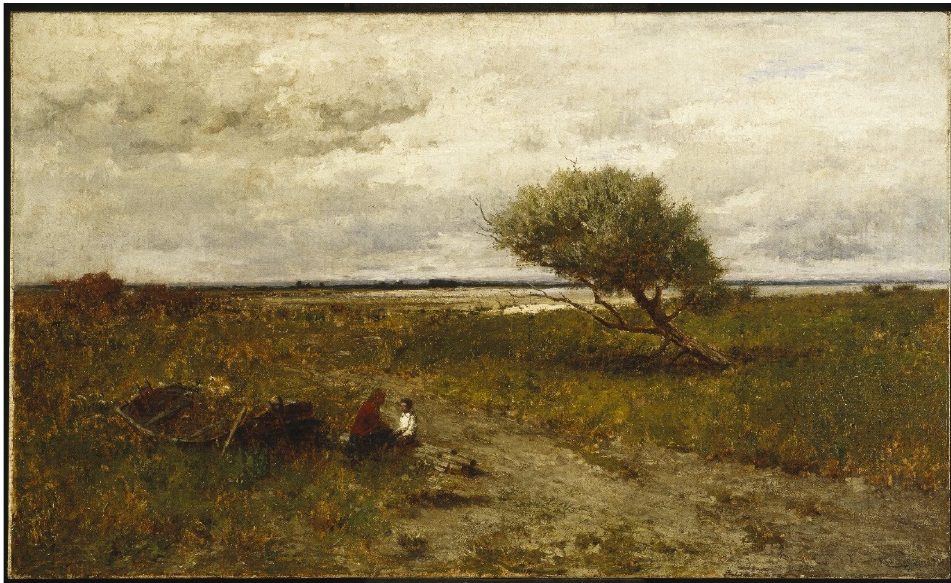
Figure 14. Robert Swain Gifford, The Coast of New England , 1880. Oil on canvas, 91.4 × 152.8 cm, Brooklyn Museum, Gift of Carll H. de Silver, 06.76 (Photo: Brooklyn Museum, 06.76_SL1.jpg).